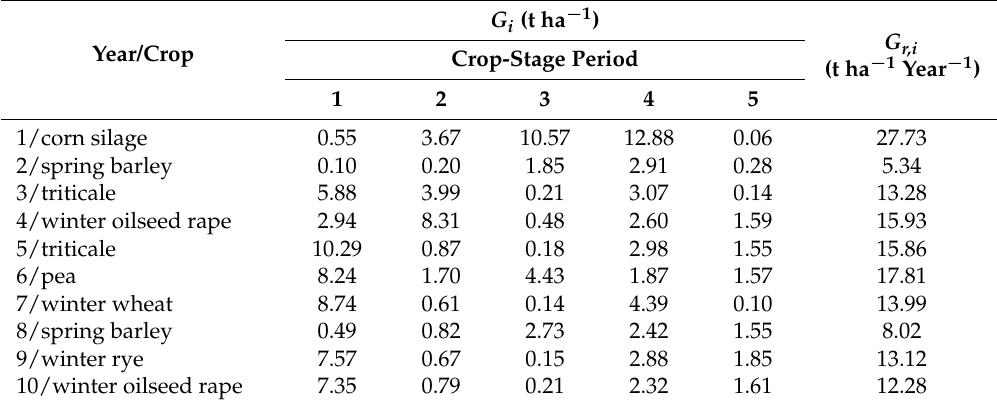
Table 3. Partial and average annual soil losses from 2001/1 parcel.